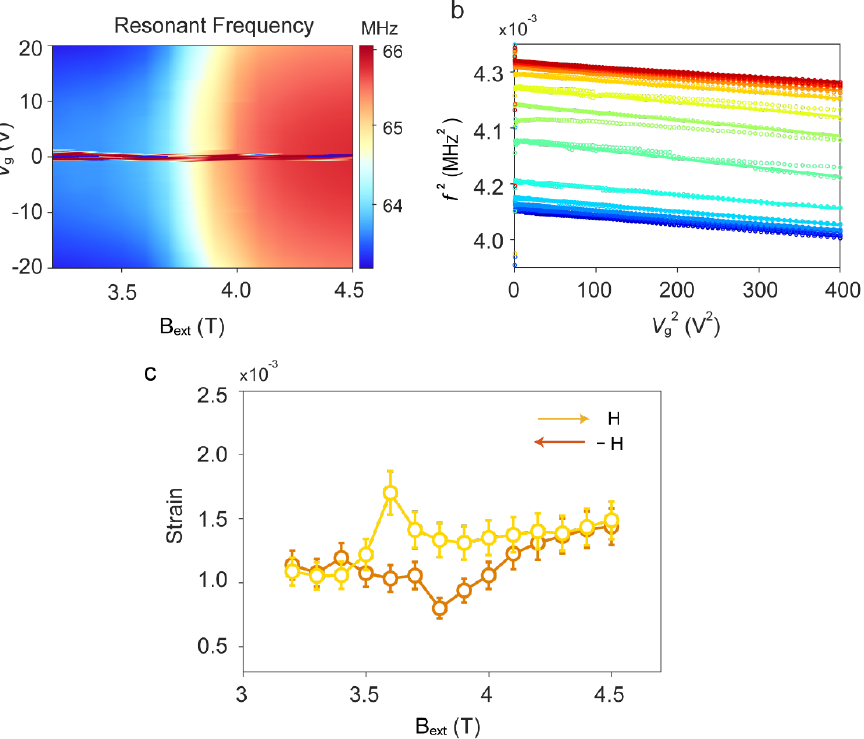
Figure 4. Strain-tuning of the phase transition in CrOCl resonators. ( a ) Colour map of the resonant frequency as a function of gate voltage V g and magnetic fields for CrOCl resonators at a temperature of 5 K. ( b ) Linear relation between f 0 2 and V g 2 with various magnetic fields sweeping from 3 T to 4.7 T. The solid line is a linear fit of data (dots). The curves from blue to red color represent different magnetic fields from 3.2 T to 4.5 T. ( c ) The stain hysteresis of CrOCl resonators versus magnetic fields. The curves with yellow and red color represent forward and reverse sweeping respectively.